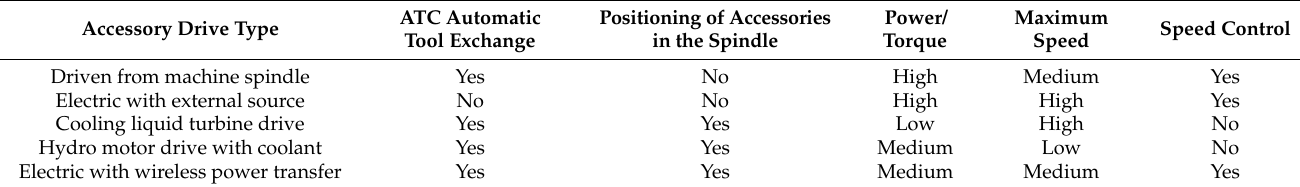
Table 1. Technological abilities of solutions for machine tool connection to its